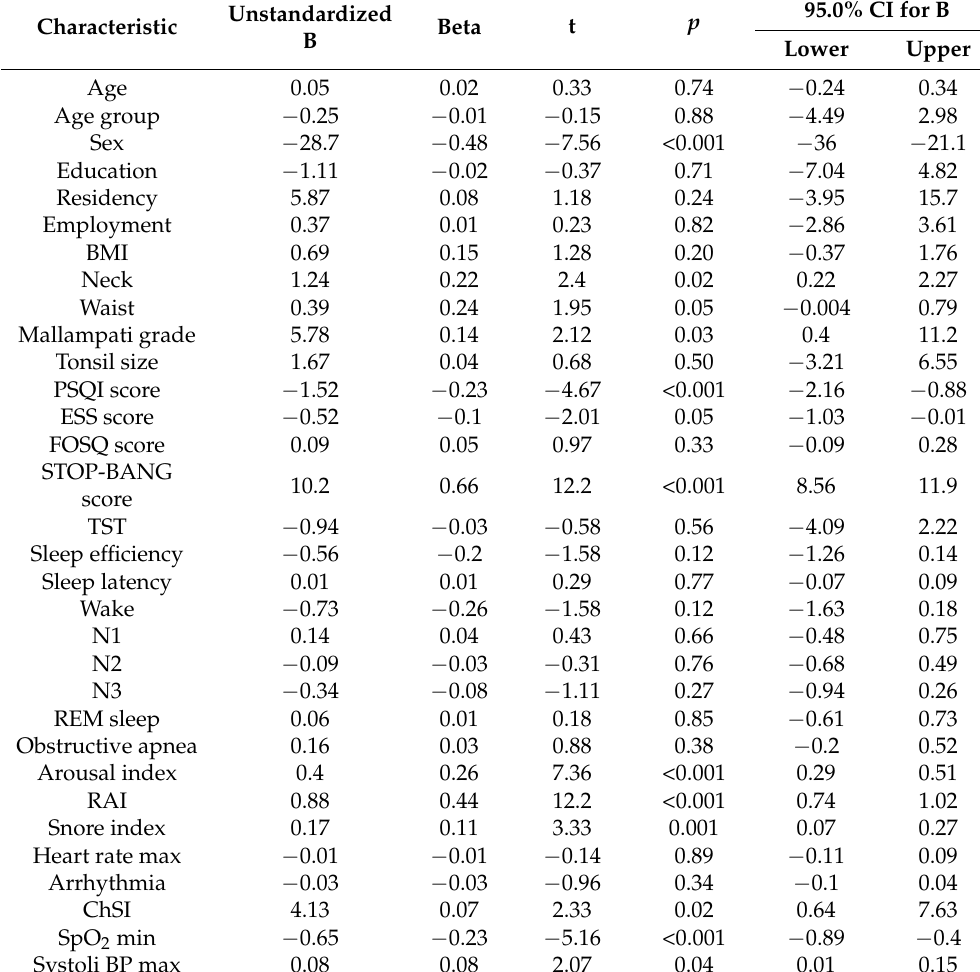
Table A1. Multiple regression analysis of factors related to AHI-defined OSA